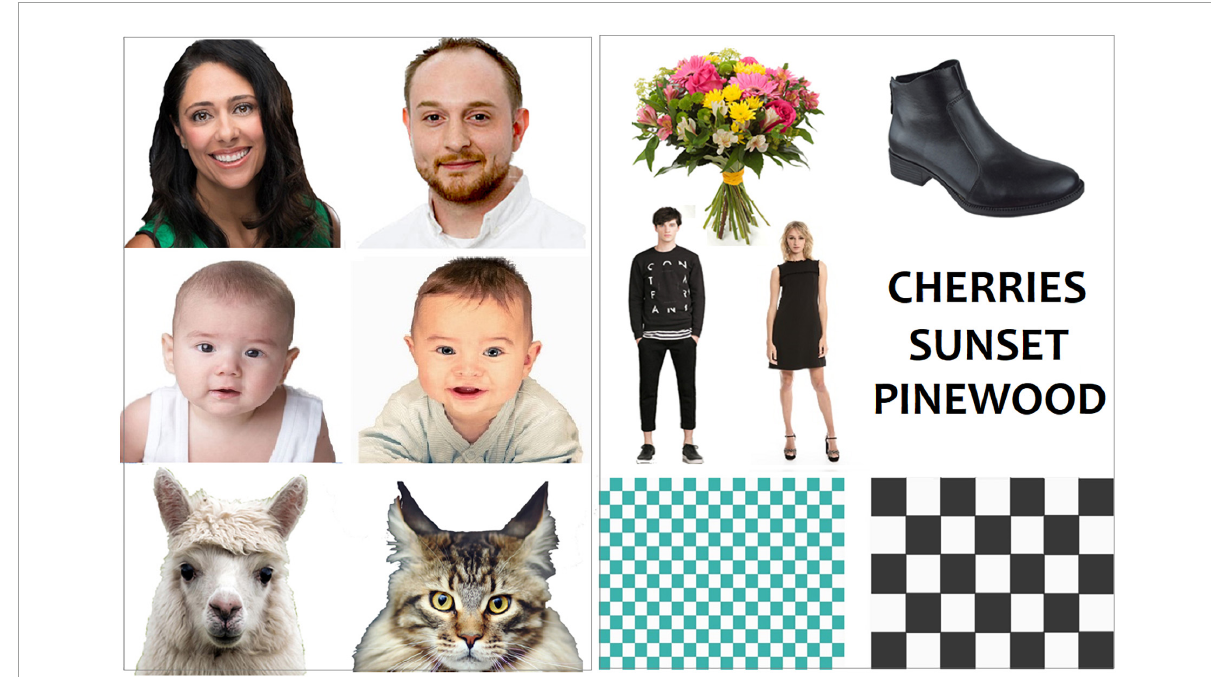
FIGURE1 Some examples of visual stimuli belonging to the various categories of living and non-living